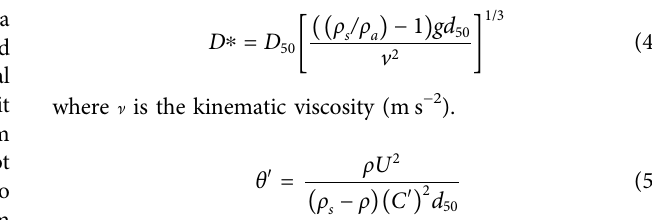
Frontiers in Earth Science |